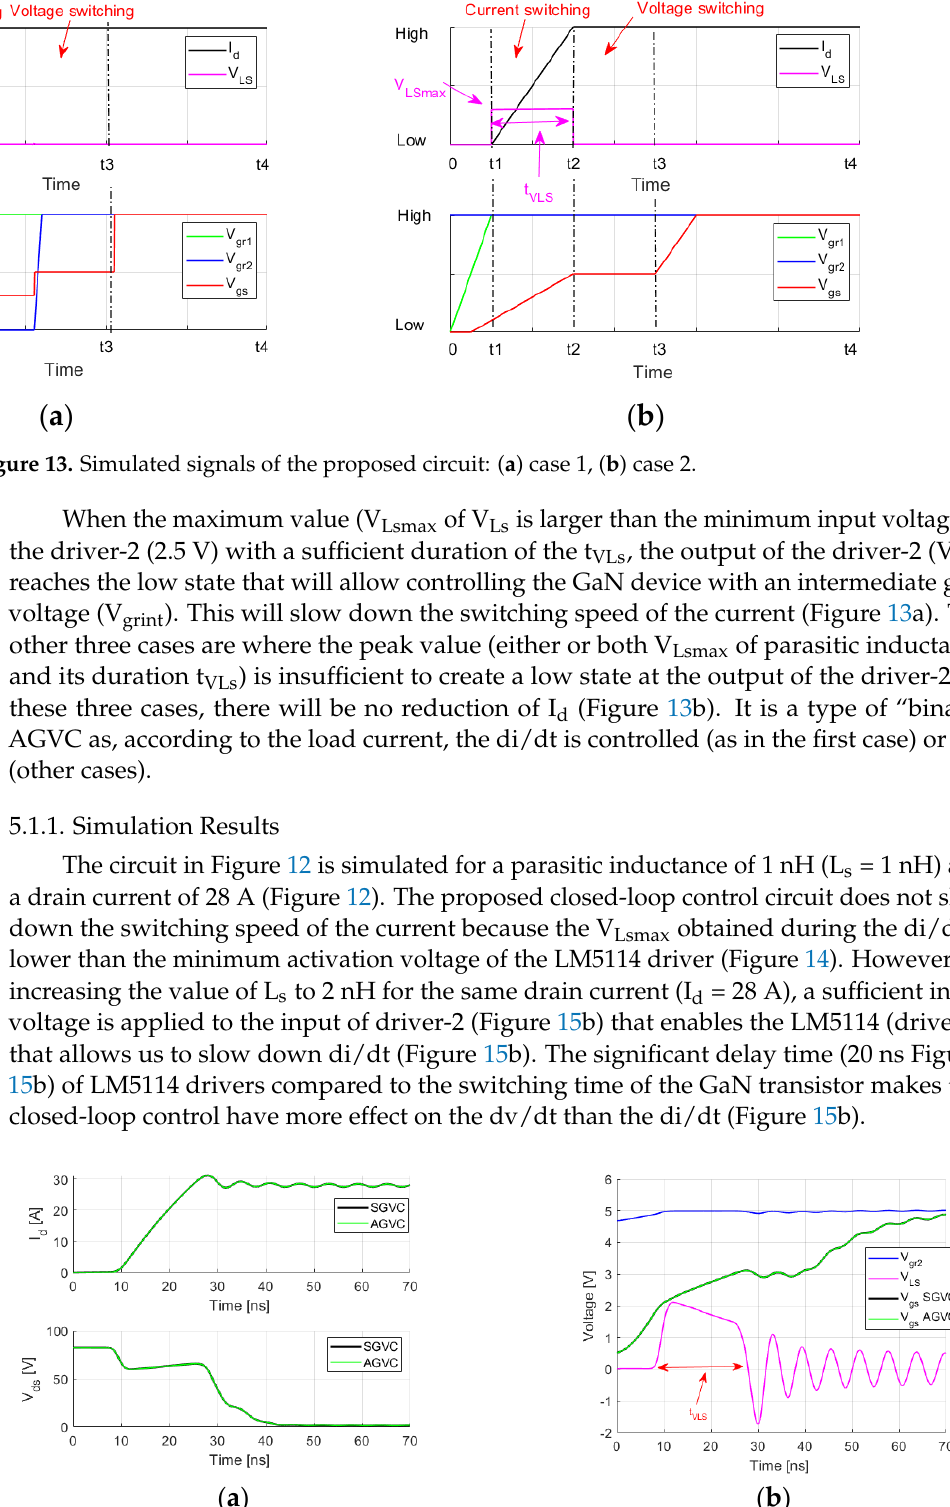
Figure 14. Simulated waveform of the main voltage and current using the proposed closed-loop active gate voltage circuit (AGVC) and standard gate voltage control (SGVC) (I d = 28 A, L s = 1 nH), ( a ) V ds and I d , ( b ) V Ls , V gr2 , V gs of AGVC, and V gs of SGVC.